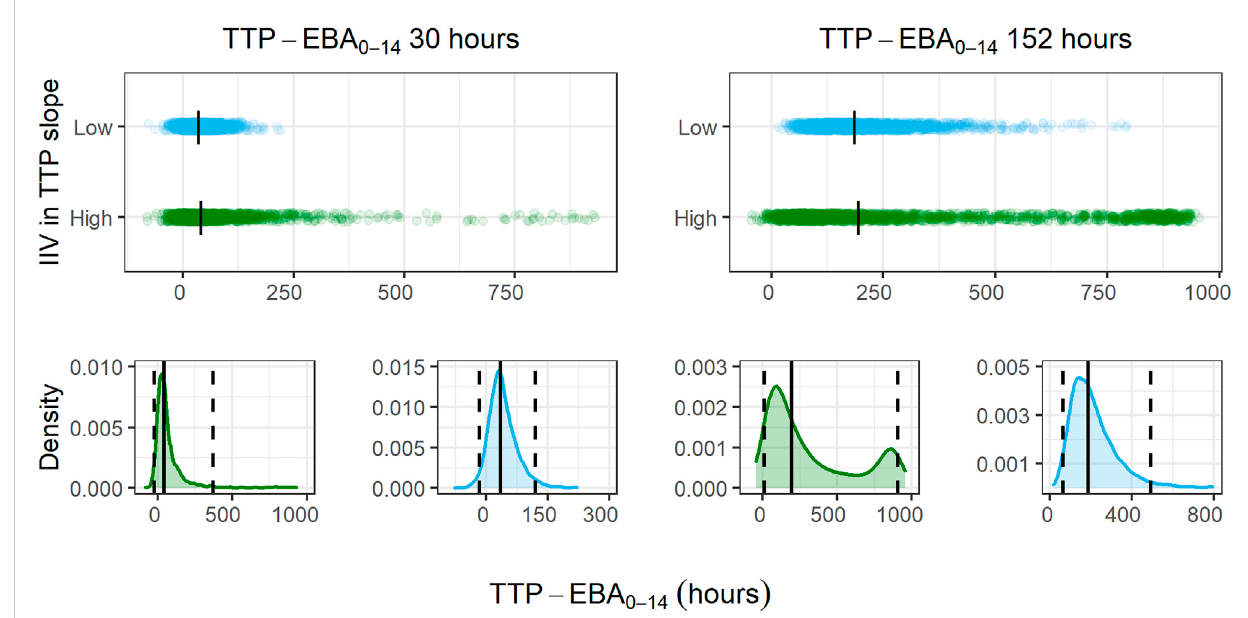
FIGURE 9 Distribution of individual simulated change in time-to-positivity between days 0 and 14 (TTP-EBA 0-14 ) values for two TTP-EBA 0-14 values; 30 h and 152 h, for different magnitudes of inter-individual variability (IIV) in TTP slope. The blue color is low IIV in EBA (22% coef fi cient of variation [CV]), and the green color is high IIV in TTP slope (104%). To visualize the spread of values, 2000 individuals per scenario of IIV in TTP slope and TTP-EBA 0-14 were simulated,andthedifferencebetweenTTPonday0andday14wascalculated.ThetoppaneloftheplotshowsthespreadofindividualTTP-EBA 0-14 values over the TTP-EBA 0-14 space. Black dashes represent individual medians. The bottom panels show density plots for the individual TTP-EBA 0-14 values. A solid black line represents the median, and dashed lines represent the 2.5th and 97.5 th percentiles of IIVs. The second peak in TTP-EBA 0-14 of 152 h and high IIV in TTP slope was related to TTP censoring at 1,008